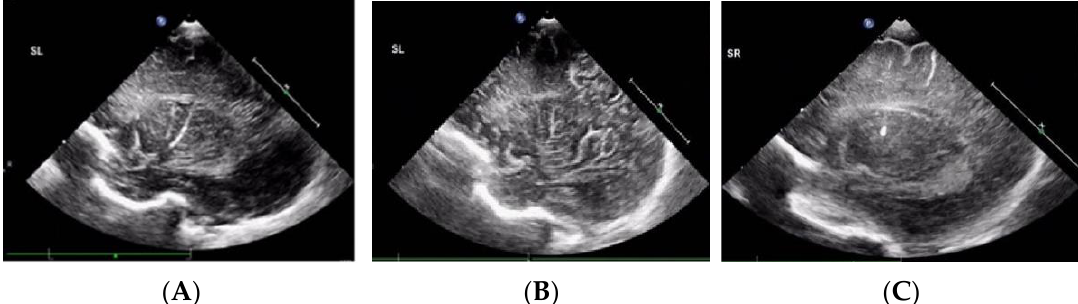
Figure 1. Lenticulostriate vasculopathy over the thalamic/basal ganglia region in three preterm infants. ( A ) Linear type. ( B ) Branching type. ( C ) Punctate type.